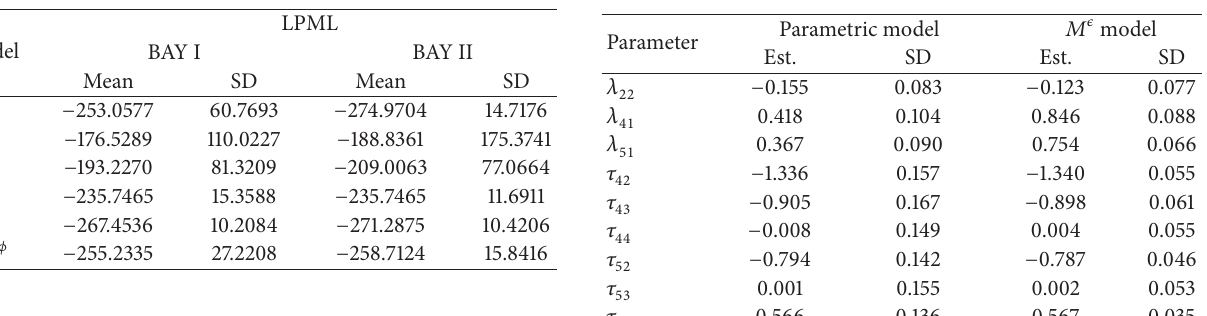
Table 4: Estimates and standard errors estimates of the parameters in analysis of political and economic risk